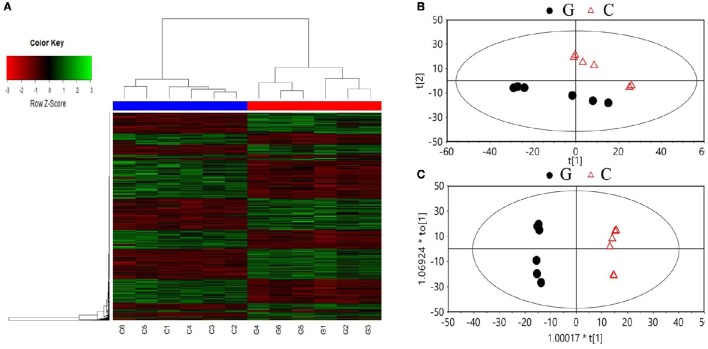
Summary of the metabolic analysis. Heat maps (A), and the principal component analysis (B), and projection to latent structure discriminant analysis (C) score plots of the metabolites analyzed by GC/GC-TOF MS in the non-chlorotic (G) and chlorotic (C) young tea leaves.